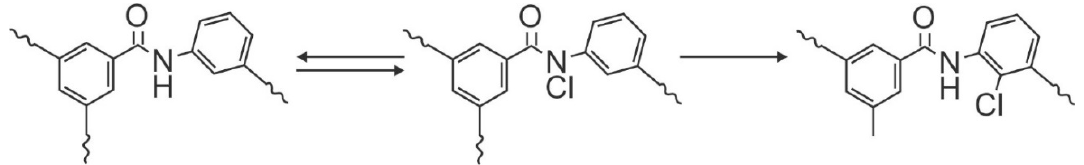
Figure 7. Chlorine damage to polyamide membrane via hydrogen-bond destruction and subsequent ring substitution via Orton Rearrangement